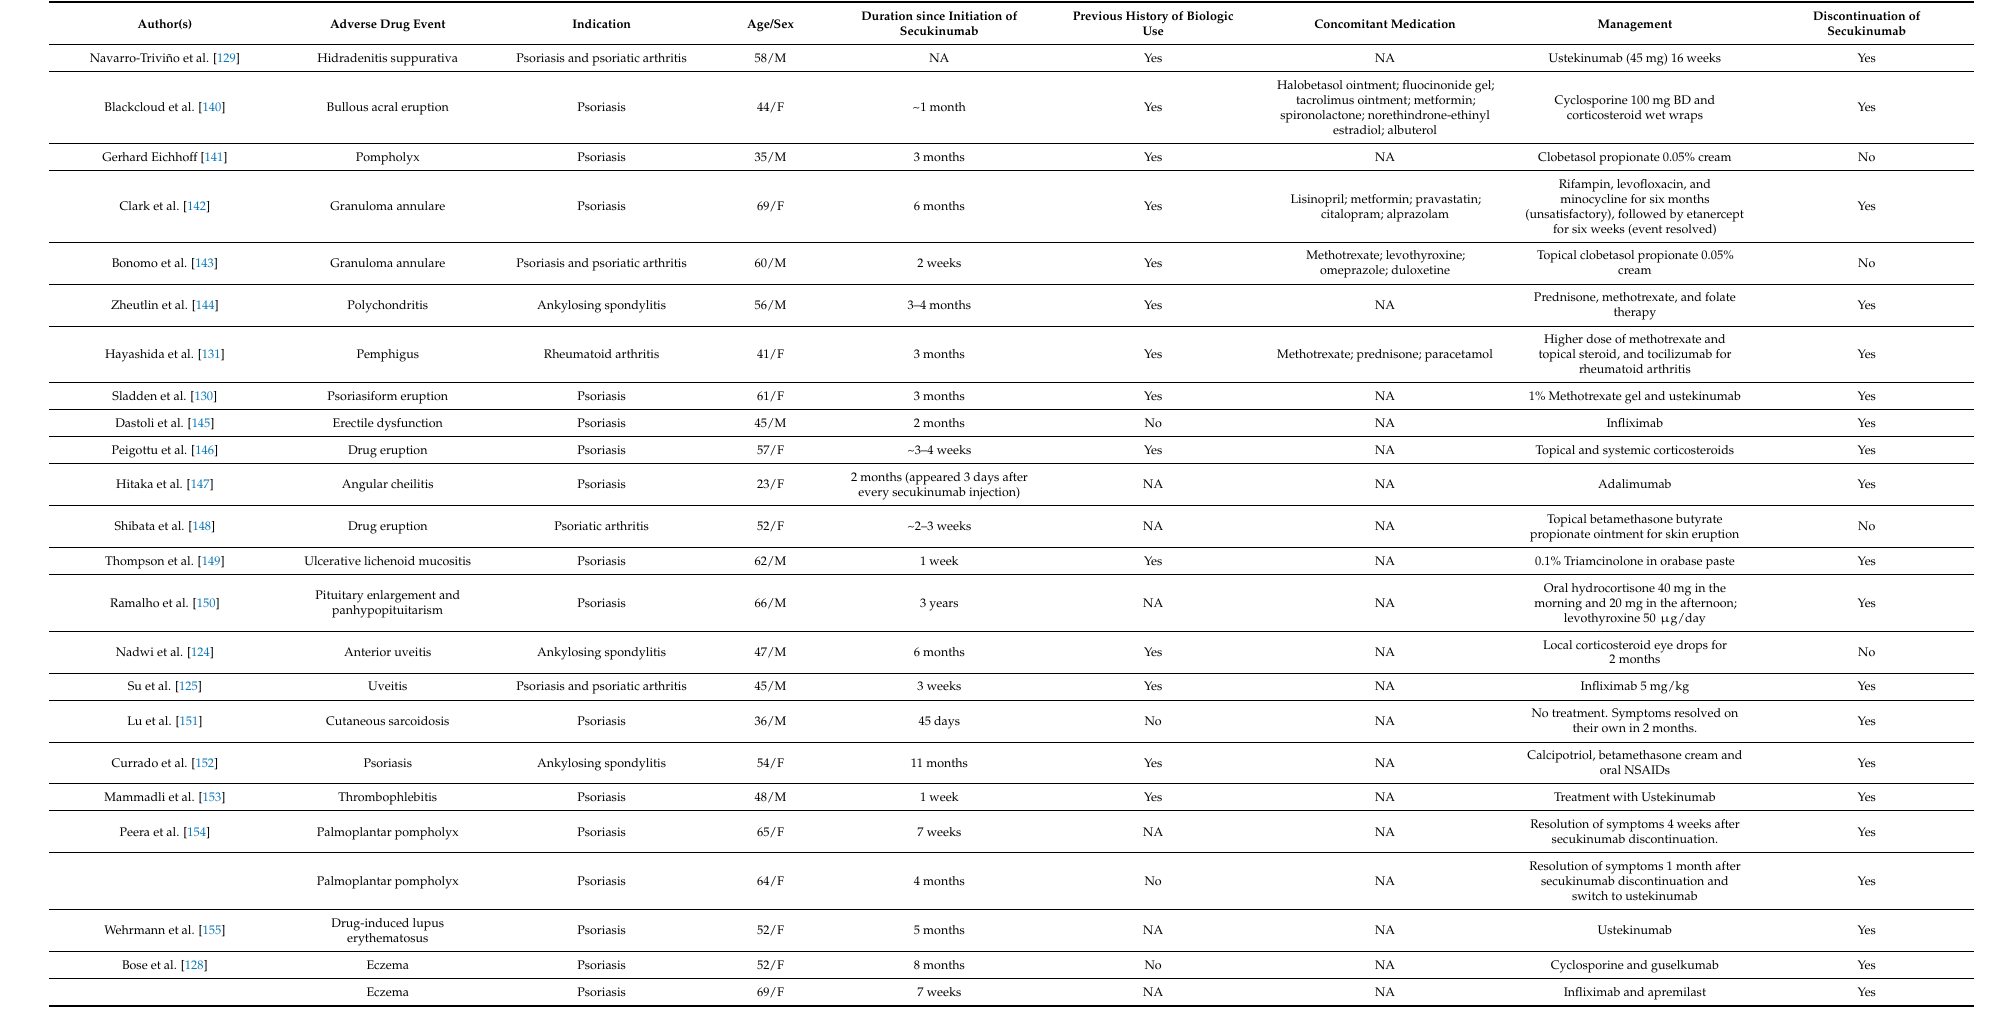
Table 5. Other adverse events reported with secukinumab